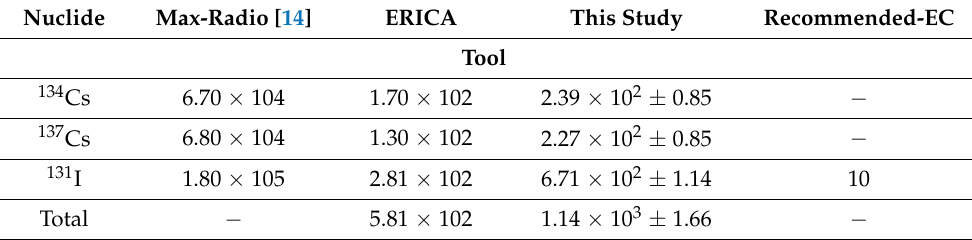
Table 8. Radiation dose rates simulated by the ERICA tool and Geant4. Nuclide Max-Radio [14] ERICA This Study Recommended-EC